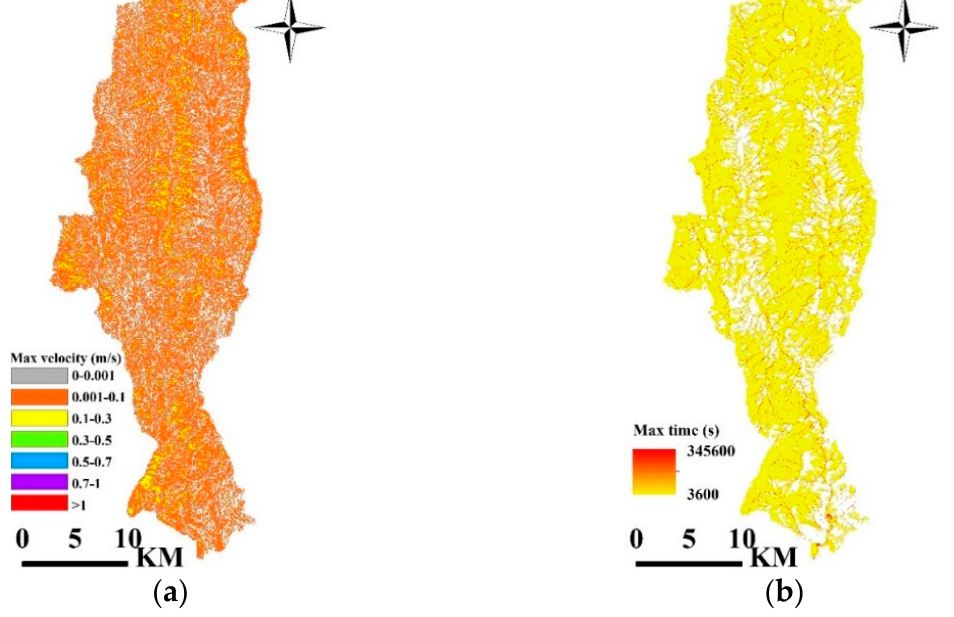
Figure 11. Spatial distribution of ( a ) flow velocity and ( b ) arrival time of the maximum inundation depth.